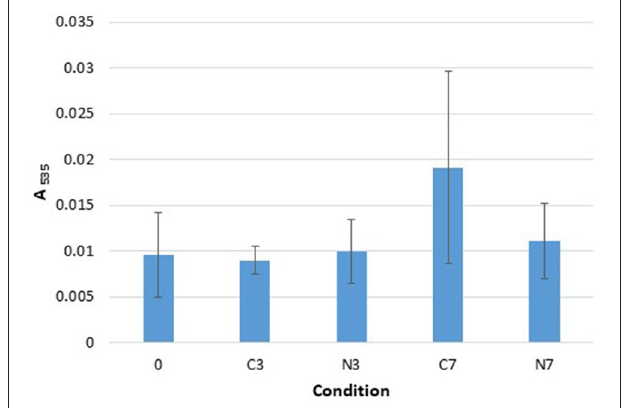
FIGURE 3 | TBARS . Absorbance, at 535nm, recorded with the Quanti Chrom TM TBARS Assay kit for the three raw milk-samples (M1–M3) at initial stage (0) and after cold-storage for 3 and 7 days at 6 ◦ C in the controls (C3, C7), and in the cold-stored while N 2 -treated conditions (N3, N7). The data are presented as mean absorbance values recorded at 535nm and obtained from three replicates for each sample. ( p = 0.0002) ( Figure 1A ). In contrast, the ADV remained unchanged for the N 2 -flushed samples